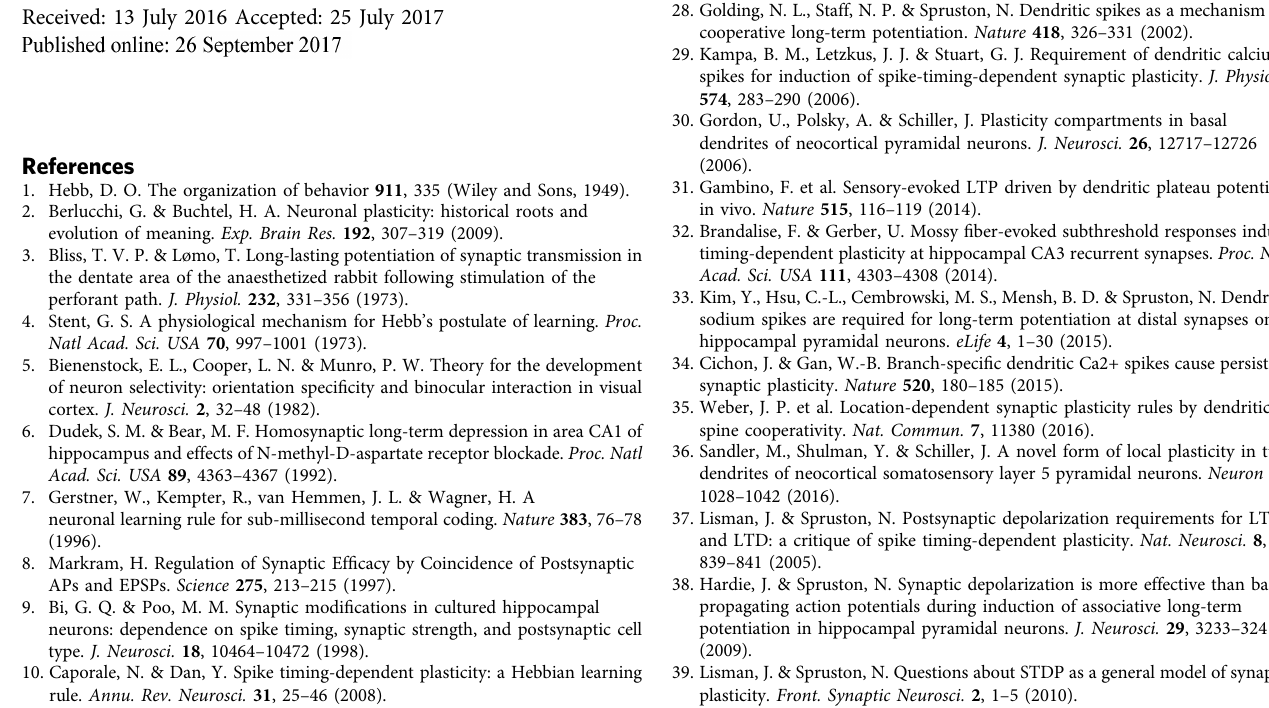
Figure 5d – f : Analogous to Fig. 5a – c, but the two pools are now connected to distal compartments on the basal dendrites. Note that we chose two distal compartments that reliably induced somatic spikes when simultaneously activated. Some other choices failed to do so, but our main result on memory retention of the distally clustered synapses remained valid in all cases. Figure 6 . For all simulations of Fig. 6, each neuron had 15 dendrites. Figure 6b – d : We implemented 40 neurons, which we divided into 4 groups of 10 neurons. The neurons are all-to-all connected, with weights initiated at the maximum bound for each simulation, and half of the connections are distal while the other half are proximal. The distal connections coming from neurons of the same feature are always clustered on the same distal compartment post- synaptically. In all neurons, a coloured noisy current was injected in the soma to induce more variability (mean = 150 pA, std = 15 pA). Moreover, each neuron had 50 extra non-plastic synapses that were used as inputs. (b, c) We activated the input synapses of one of the groups of 10 neurons (the group was selected randomly) by activating the input synapses to the relevant neurons at an average rate of 350 Hz during 10 ms, followed by a 250ms interval without inputs. We repeated this for 100 s, and randomly chose one of the groups for every activation. The total synaptic strength of the network was stored every second. Figure 6e – j : We divided a network of 60 neurons into 2 groups of 40 neurons each ( ’ associative memories ’ ), each group sharing 20 neurons. Moreover, the groups were divided into 4 subgroups of 10 neurons ( ’ features ’ ), and two of these subgroups were shared. The neurons were all-to-all connected, with weights initiated at the minimum bound for each simulation, and half of the connections are distal while the other half are proximal. The distal connections coming from neurons of the same feature were always clustered on the same distal compartment post-synaptically. In all neurons, a coloured noisy current was injected in the soma to induce more variability (mean = 150 pA, std = 15pA). Moreover, each neuron had 50 extra non-plastic synapses that were used as inputs. An activation event consisted of selecting one associative memory and activating the input synapses to the 40 relevant neurons at an average rate of 350 Hz during 10 ms, followed by a 250ms interval without input. The selection of the associative memory was done randomly, but the probabilities changed during the simulation: during the fi rst 100 s, the fi rst and second associative memories had 90 and 9% chance of activation respectively, while between 100 and 200 s the probabilities were reversed (9 and 90%, respectively). Finally, between 200 and 300 s the activation probabilities were as in the fi rst phase (90 and 9%, respectively). The total synaptic strength from subgroups 4 to subroups 1 and 6, and from subgroup 3 – 4 were stored every second. Moreover, the total synaptic weight matrix was stored after 200 and 300